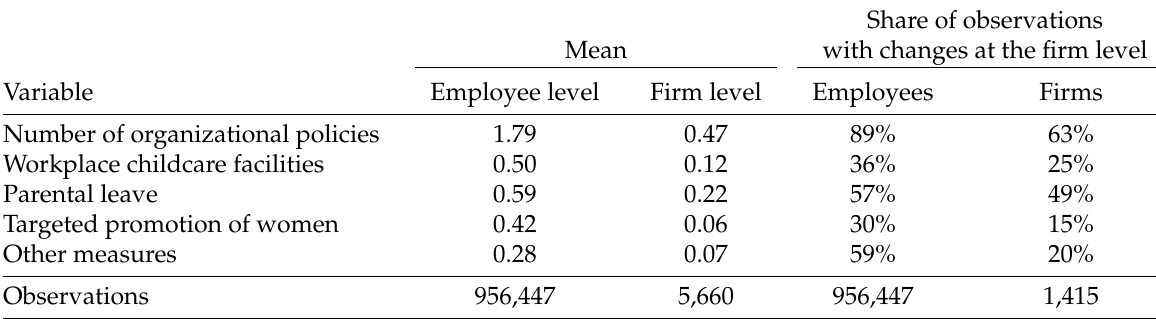
Table 2: Changes in practices promoting gender equality at the firm